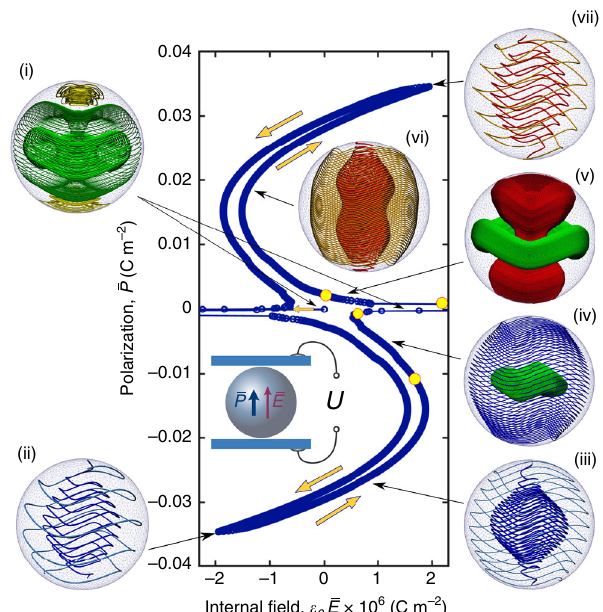
Fig. 3 Field-induced topological states in PbZr 0.6 Ti 0.4 O 3 (PZT). The (cid:1) P (cid:2) (cid:1) E polarization curve (blue line) demonstrates hysteretic behavior due to the series of transitions (denoted by yellow circles) between different polarization topological states (i – vii) in the 25 nm nanoparticles of the PZT. The helices with the “ upward ” and “ downward ” polarization fl ux are shown in brick-red and blue, respectively, the green colour depicts the localized Hop fi on polarization lines, and yellow denotes the closed vortices. The block yellow arrows show the direction of the evolution along the hysteresis loop. The inset shows a conceptual setup. The applied voltage, U , induces average polarization, (cid:1) P , and average internal fi eld, (cid:1) E . The nanoparticle is oriented to have its [111] crystallographic axis perpendicular to the capacitor's